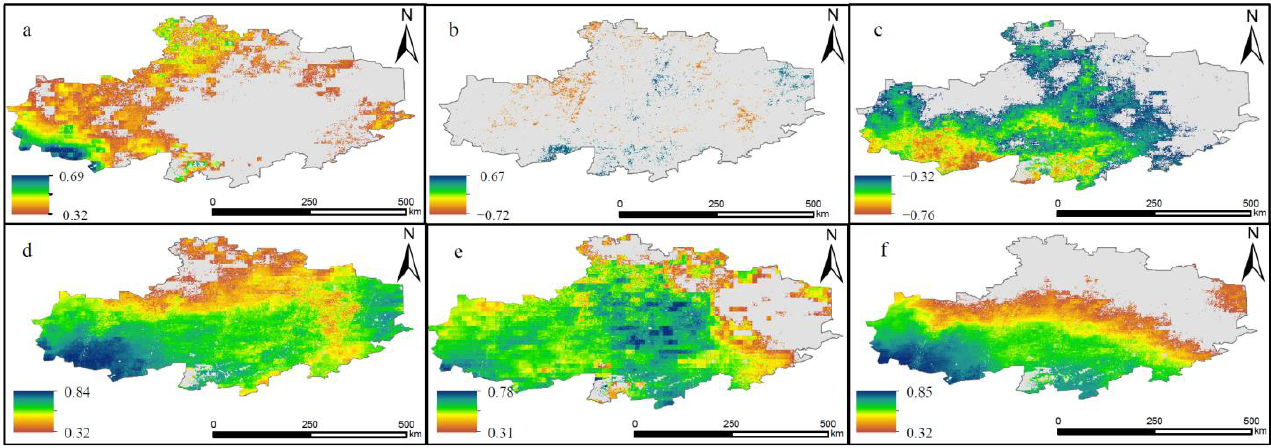
Figure 7. Spatial distribution of bias correlation coefficients between PET and environmental factors passing significance test throughout Akmola State: ( a ) PET and MAT bias correlation coefficient; ( b ) PET and NDVI bias correlation coefficient; ( c ) PET and SWC bias correlation coefficient; ( d ) PET and Srad bias correlation coefficient; ( e ) PET and ST bias correlation coefficient; and ( f ) PET and wind speed bias correlation coefficient.